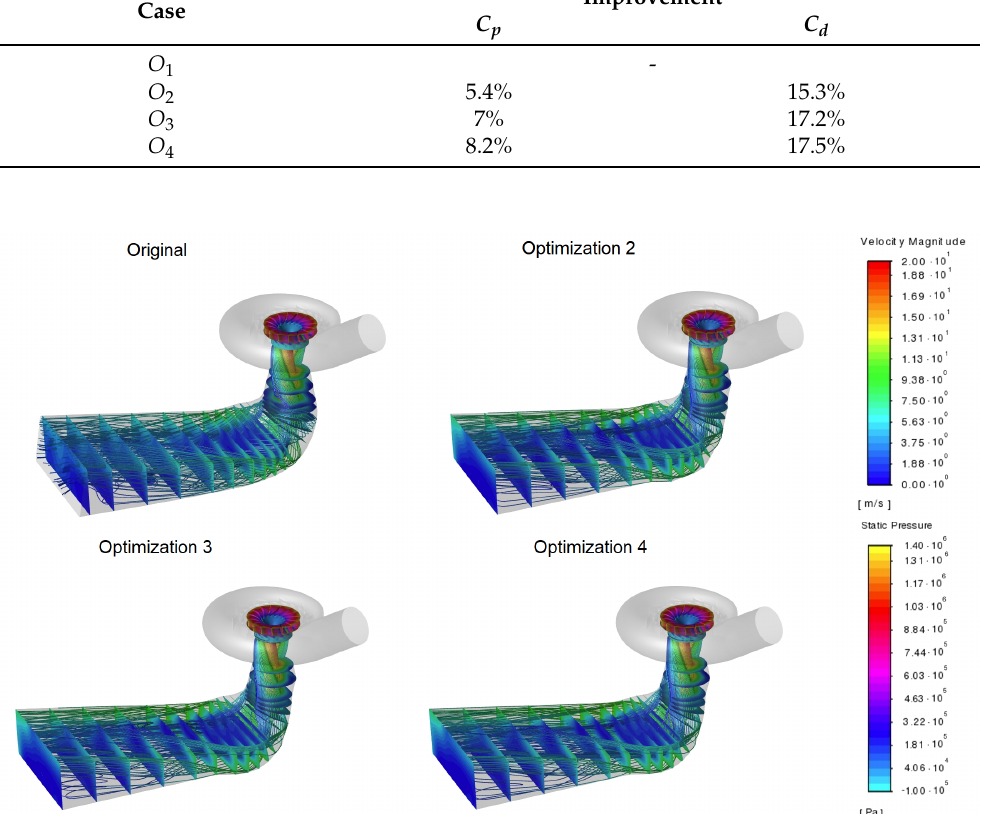
Figure 5. Runner colored to show static pressure and the contours of the velocity magnitudes in several draft tube cross-sections, with the pathlines starting from the runner